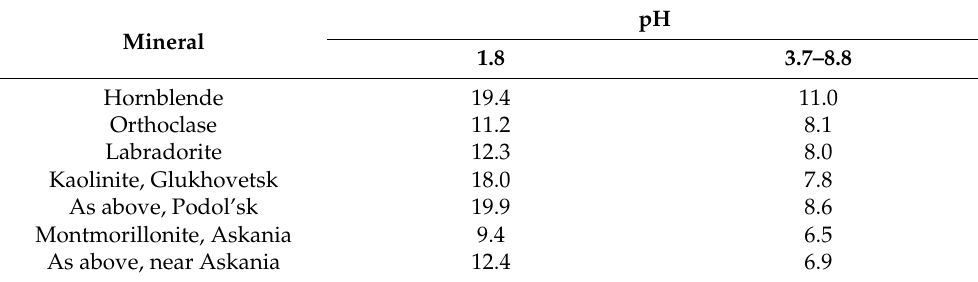
Table 5. Amount of silicon passed into solution in the experiments on phosphatization of silicates at the maximum initial concentration of phosphates 1 , % of the initial concentration in the mineral [19].